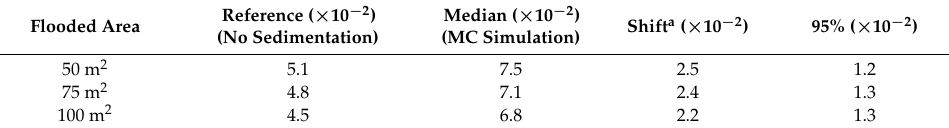
Table 4. Summary statistics of probability of infection per year for children in the ‘Tuindorp’ catchment.